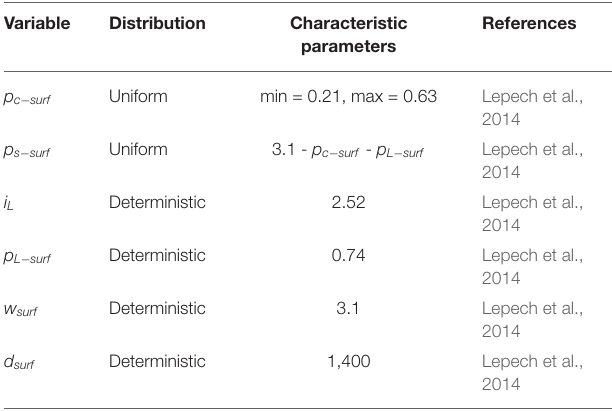
TABLE 7 | Surface treatment environmental impact modeling variables, distributions, and parameters.